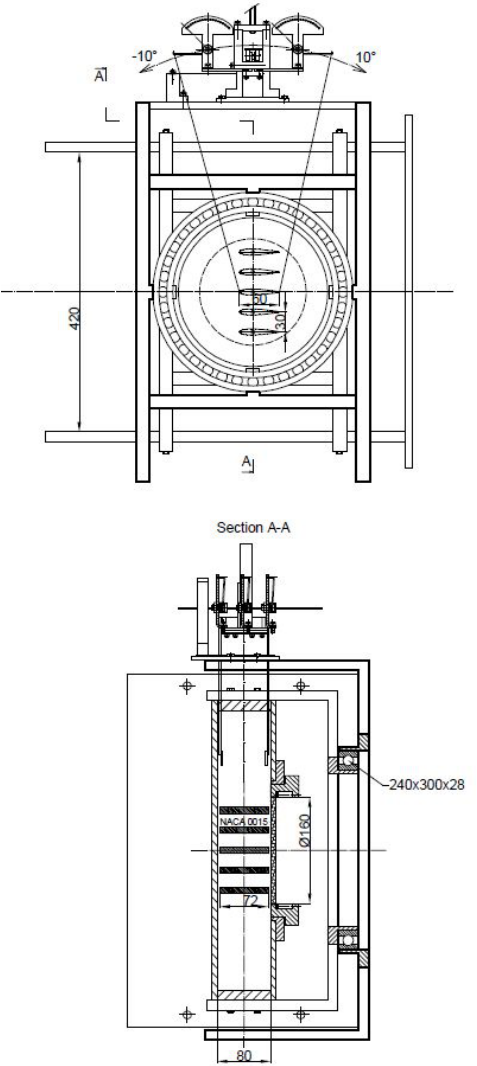
Fig. 4. The scheme of the test section with adjustable angle of attack of the cascade.